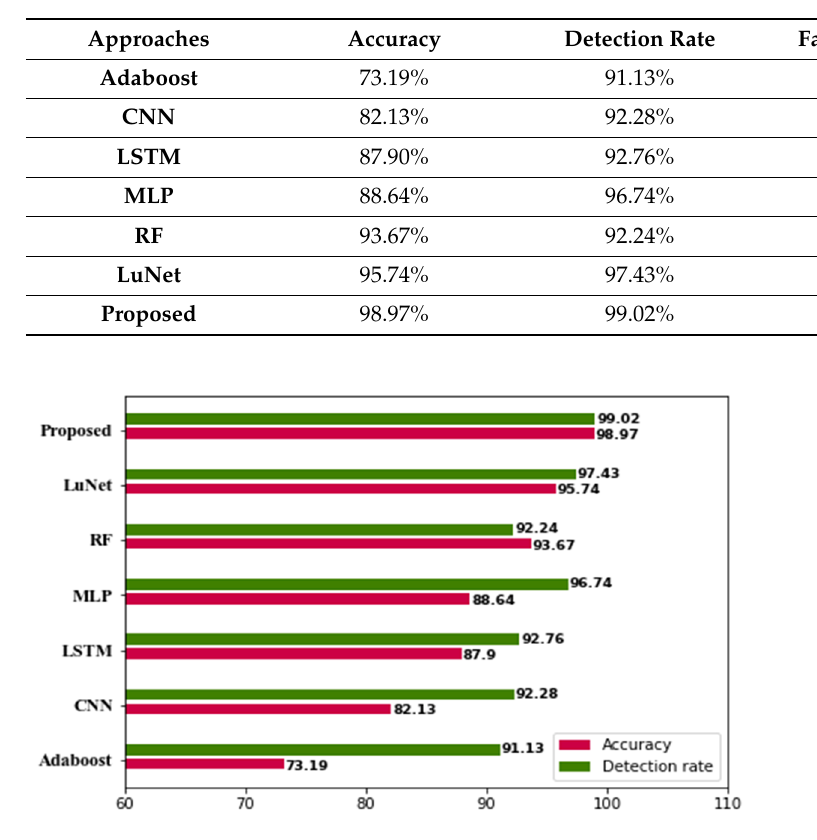
Figure 11. Accuracy and detection rate compared with existing approaches.